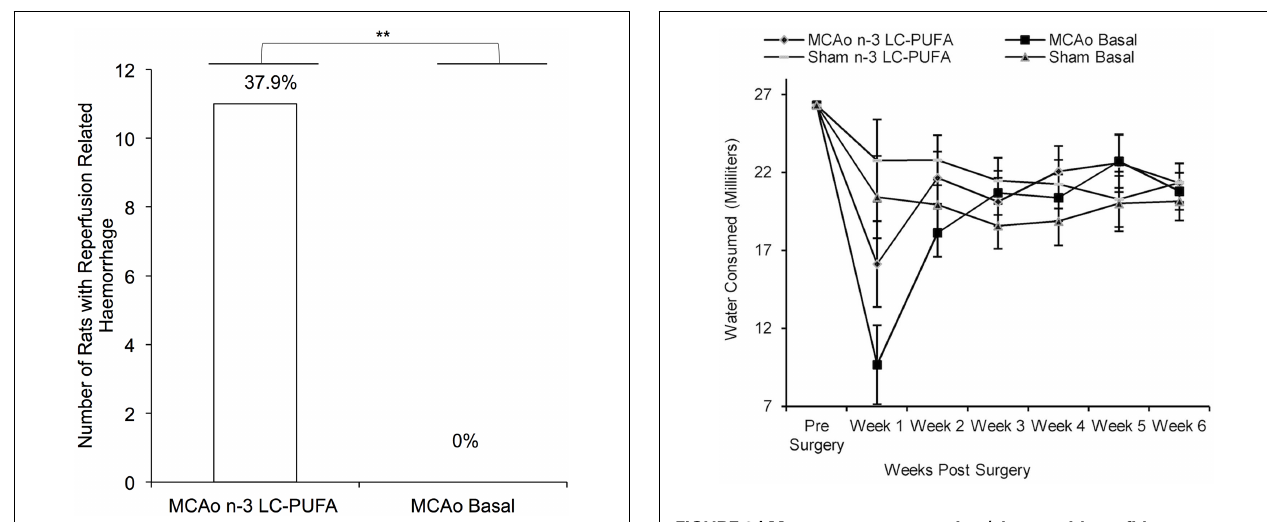
FIGURE 3 | Mean water consumption (shown with confidence intervals), between surgery and diet conditions from week 1 until week 6 post-surgery . Note the large drop in water consumption immediately after surgery and the rapid recovery in drinking behavior, by week 2 post-surgery, and by the time that ischemia associated motor impairments were no longer obvious. MCAo, middle cerebral artery occlusion surgery condition; Sham, Sham surgery condition; Basal, basal diet fed rats; n -3-LC-PUFA, polyunsaturated fatty acid supplemented